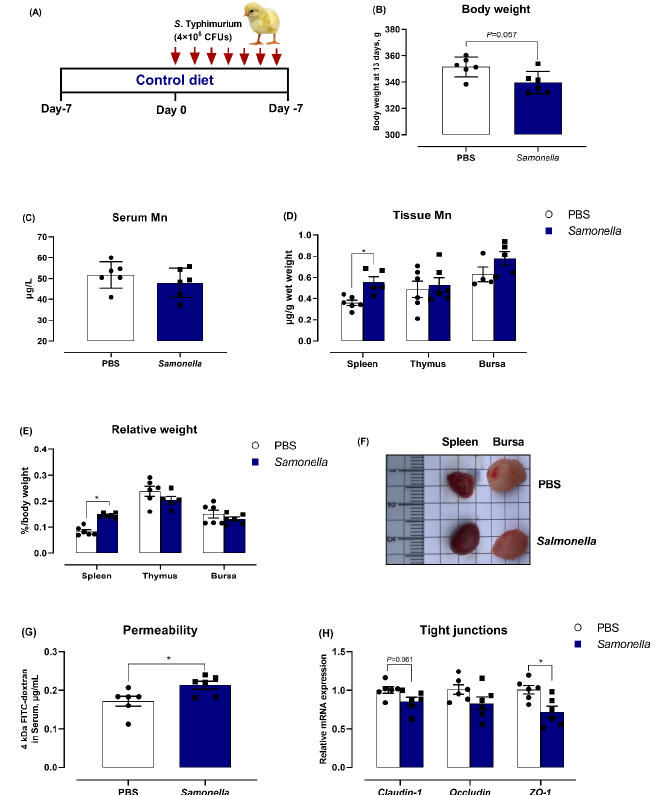
Figure 1. Oral S . Typhimurium infection induces Mn redistribution and splenomegaly and impairs the intestinal barrier. ( A ) Schematic presentation of the S . Typhimurium-challenge model. Birds were fed the control diets (the basal diet plus additional 40 mg Mn/kg) for 14 days and challenged with S . Typhimurium (4 × 10 8 CFUs) or phosphate buffer saline (PBS) at 7 days-of-age. ( B ) Body weight changes were assessed. Levels of Mn were measured in ( C ) serum and ( D ) spleen, thymus, and bursa. ( E ) and ( F ), the relative weight of spleen, thymus and bursa were examined. The intestinal barrier was evaluated by permeability using of ( G ) fluorescein isothiocyanate (FITC)-dextran and ( H ) the mRNA level of tight junctions, including claudin-1, occludin, and zonula occludens-1 (ZO-1) in jejunal mucosa. Data represent means with standard deviation. * p < 0.05 .